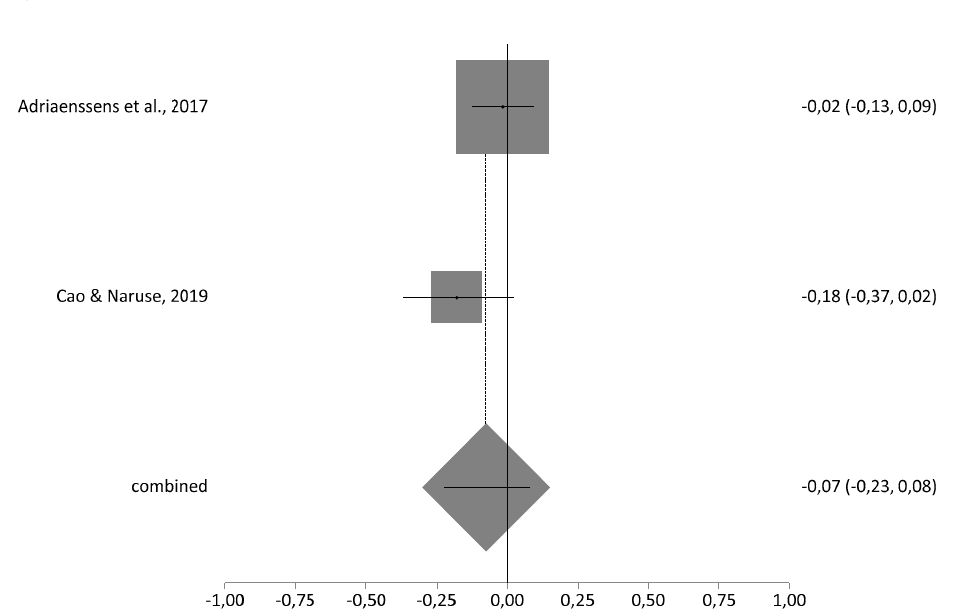
Figure 2. Forestplot of correlation between emotional exhaustion and age.